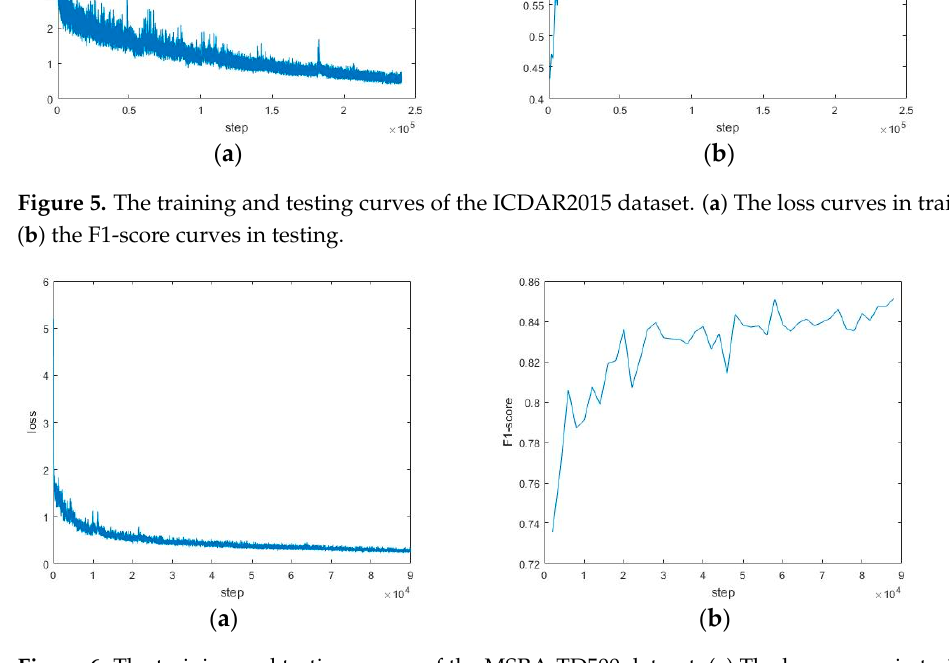
Figure 5. The training and testing curves of the ICDAR2015 dataset. ( a ) The loss curves in training; ( b ) the F1-score curves in testing.